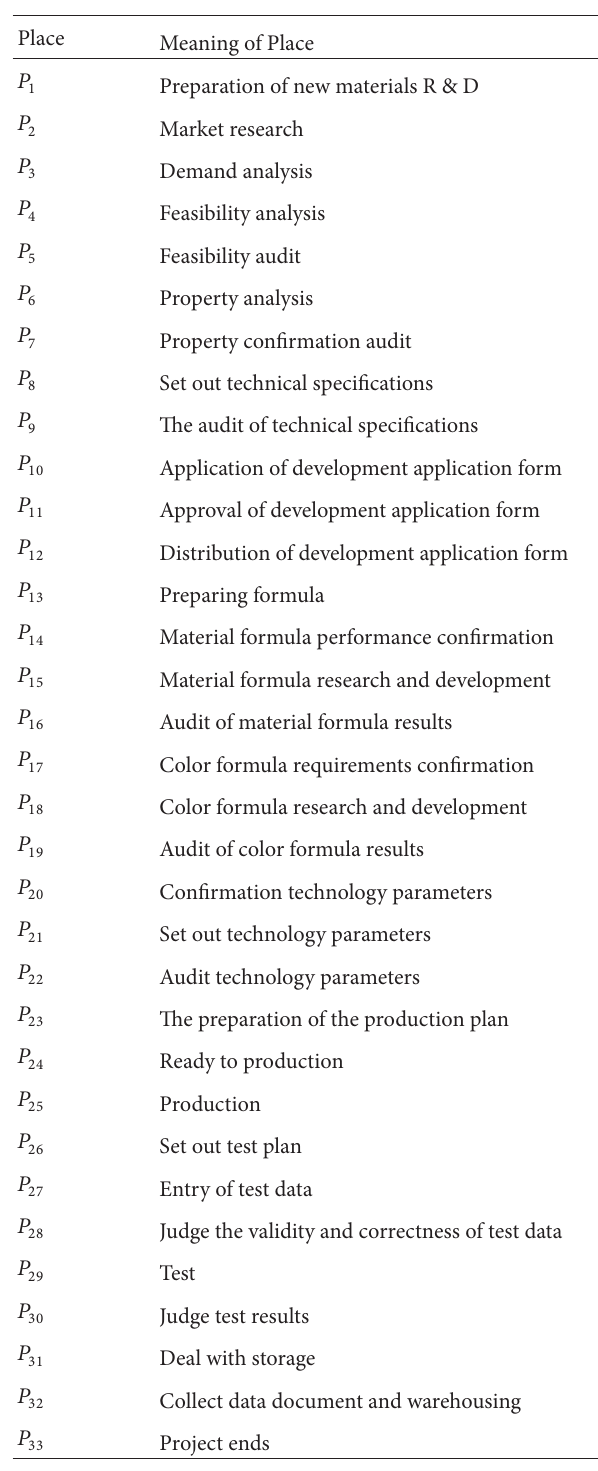
Figure 10: Looping routing. Table 1: Name of Place and its